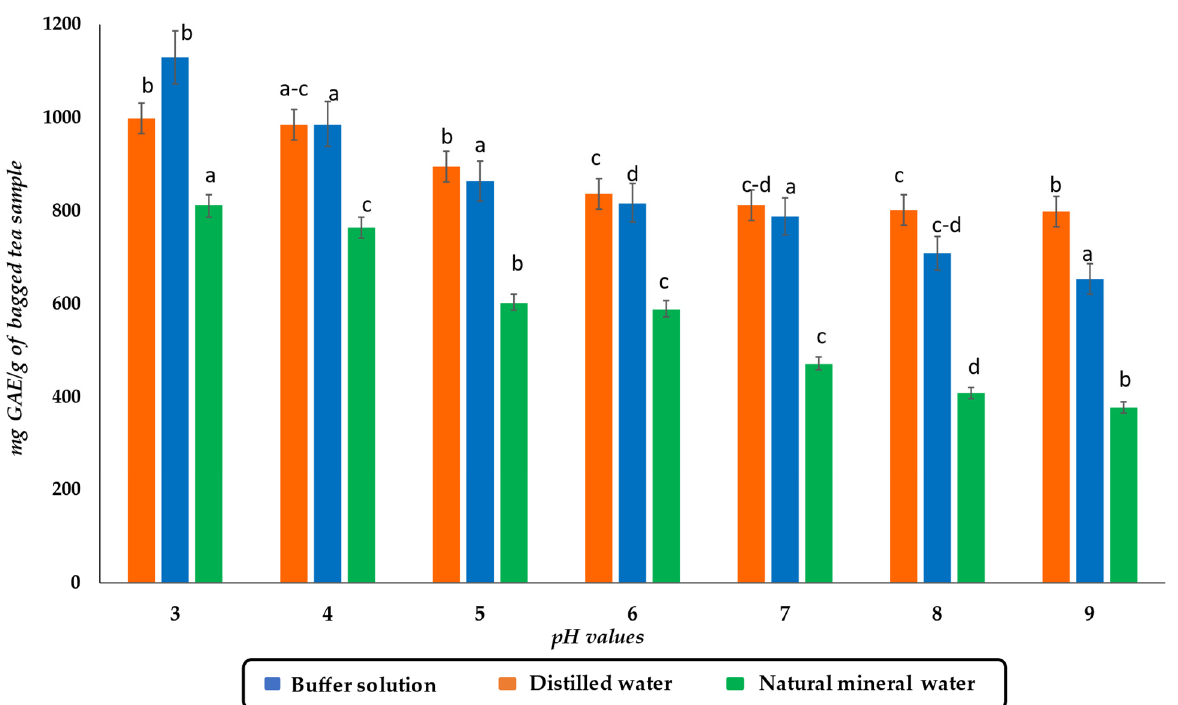
Figure 5. TPC of green tea infusion (mg GAE/g) prepared at different pH values between 3 and 9, in distilled water; in buffer solution, and in natural mineral water at 100 °C for 10 min. Error bars are ±standard deviation. Same letters indicate a significant difference according to the ANOVA test ( p < 0.05).